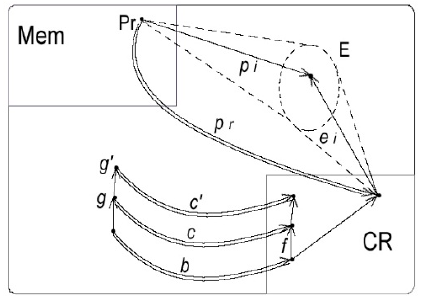
Figure 6. The landscape of CR is an evolutive system whose components b, c, c’, pr, . . . are representede by the curved arrows (their links being the rectangles between them).